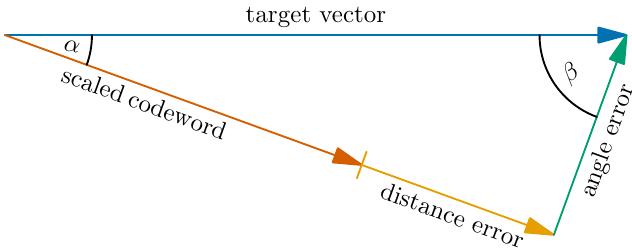
Figure 1. Decomposition of the approximation